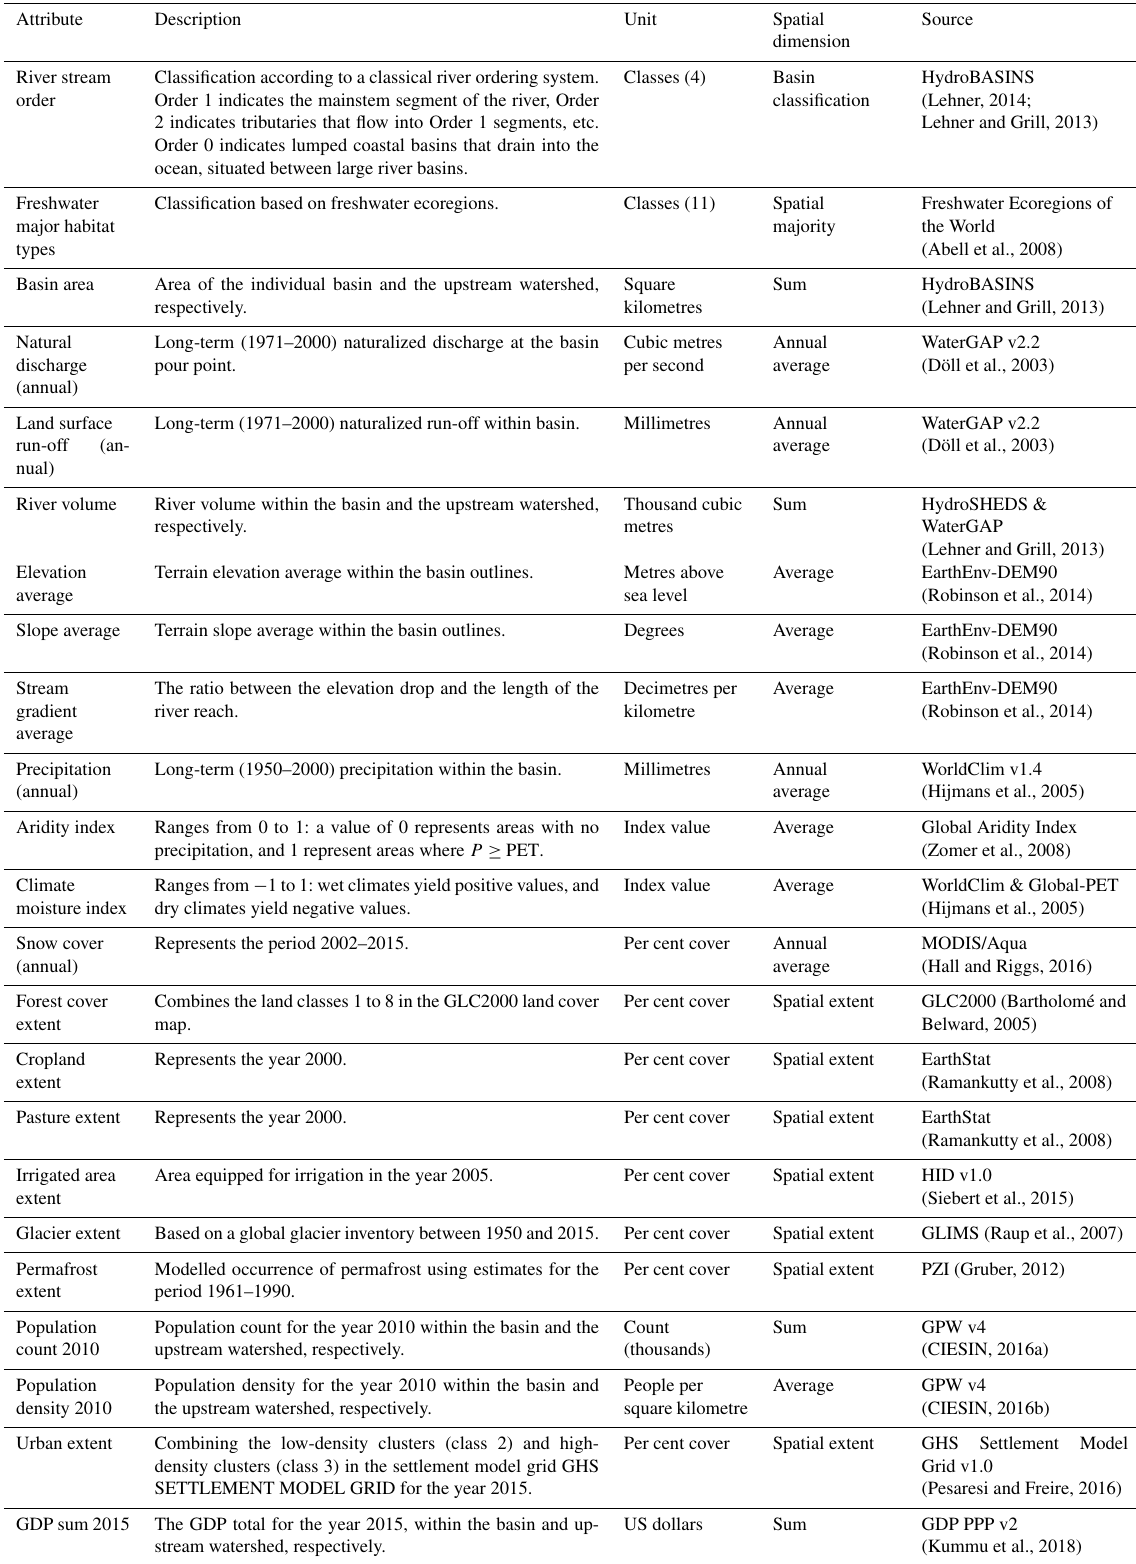
Source dimension